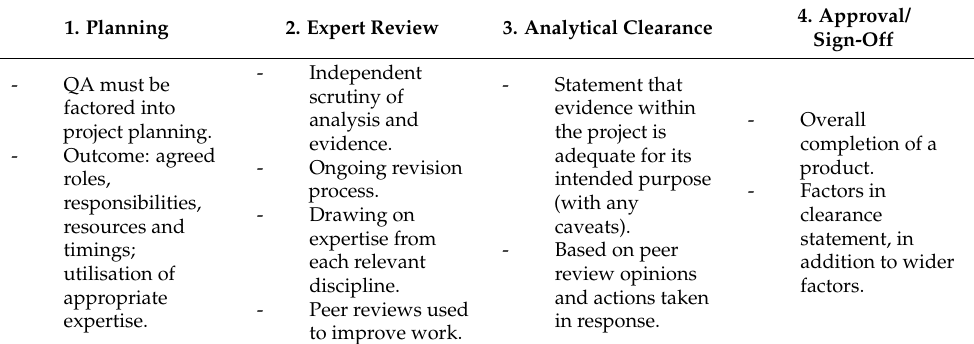
Table 4. The United Kingdom’s four-step quality assurance (QA) framework for modelling in